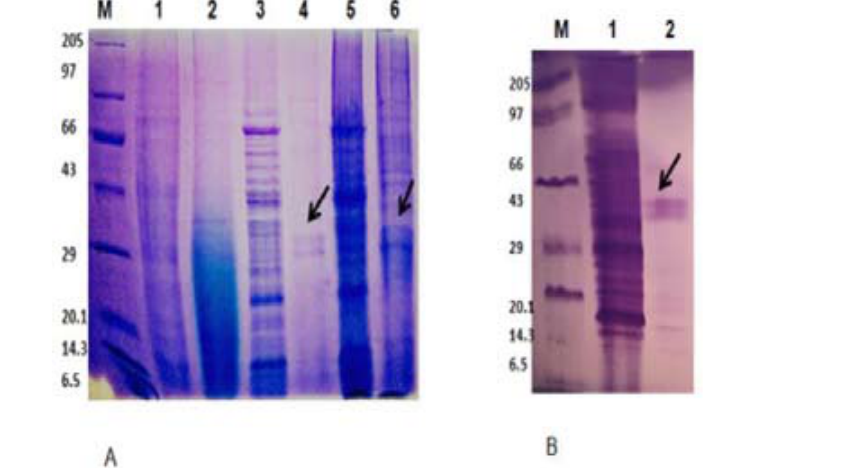
Fig.2 Transformation of linear pPICZαA-Tf CP8 into P. pastoris X-33 and screening for recombinants of P. pastoris X-33 TfCP8. a. YPD Zeocin 100ug/ml Negative control b. YPD Zeocin 100ug/ml spread with 100 ul of transformed Pichia cells c. YPD Zeocin 100ug/ml spread with 100 ul of transformed Pichia cells d. Screening for genomic integration of Tf CP8 gene M-Molecular weight marker, 1-6 wells were loaded with PCR products to identify the positive clones of Pichia for the CP8 gene.